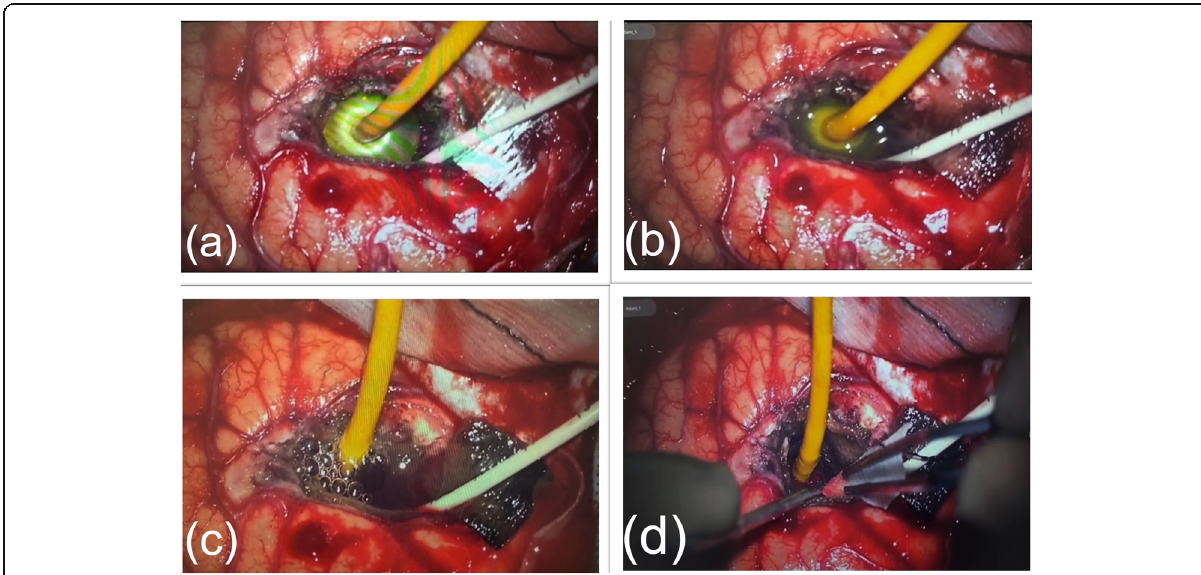
Fig. 2 a , b Placement of Foley catheter into the tumor cavity after tumor resection and inflation of bulb. c , d Deflation of Foley bulb and complete hemostasis